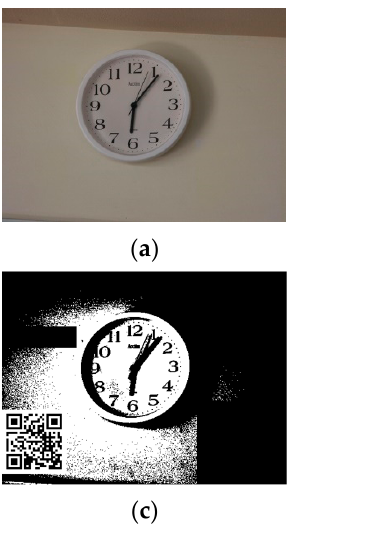
Figure 12. Multi-Watermarked image, ( a ) Watermarked image PSNR = 48.63 dB, SSIM = 0.9964, NDC = 0.0055, ( b ) Exhibited FI watermark, ( c ) Exhibited QR watermark, ( d ) Exhibited UNAM watermark.